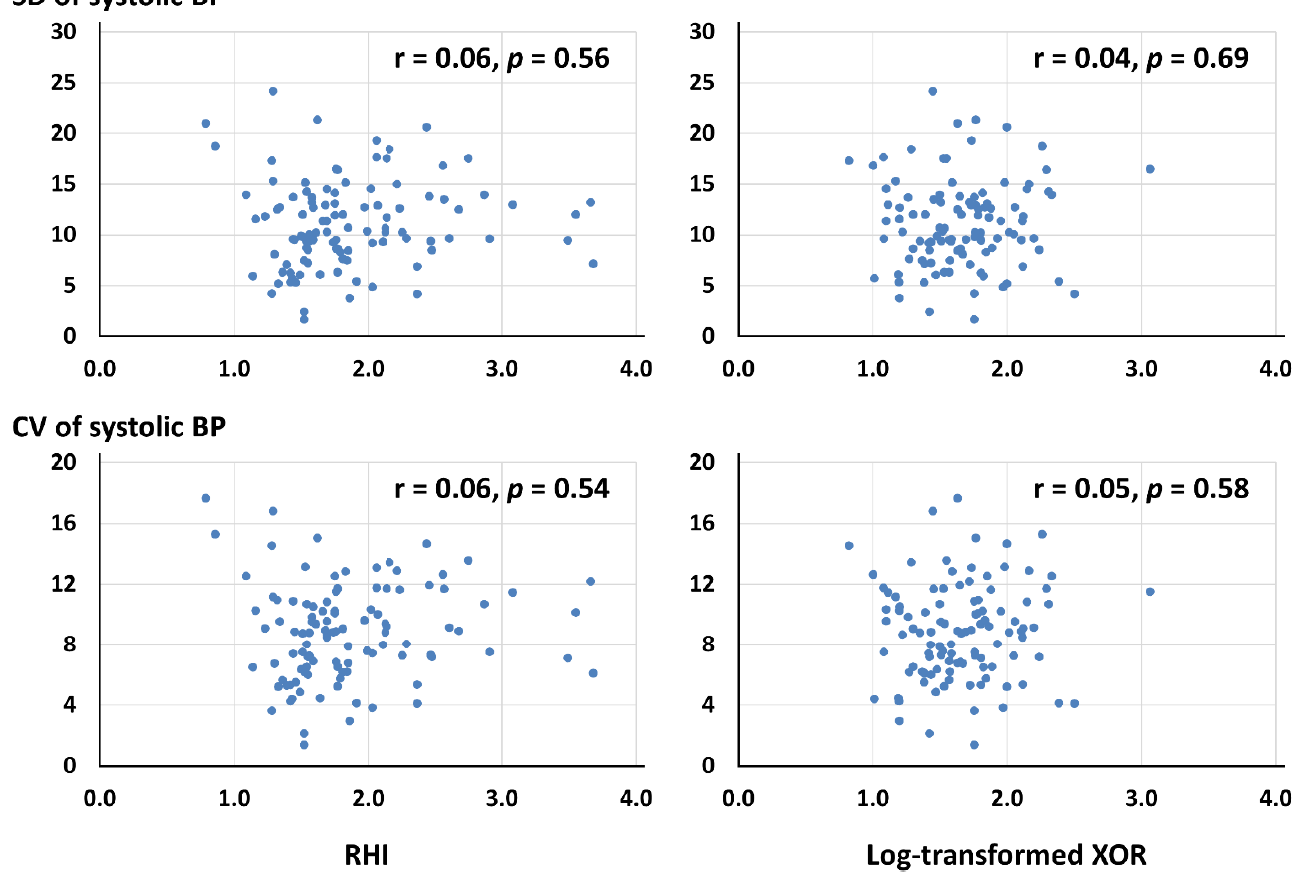
Figure 1. Relations of the RHI and the log-transformed XOR to the SD and the CV of the systolic BP. BP: blood pressure, CV: coefficient of variation, RHI: reactive hyperemia index, SD: standard deviation, XOR: xanthine oxidoreductase.